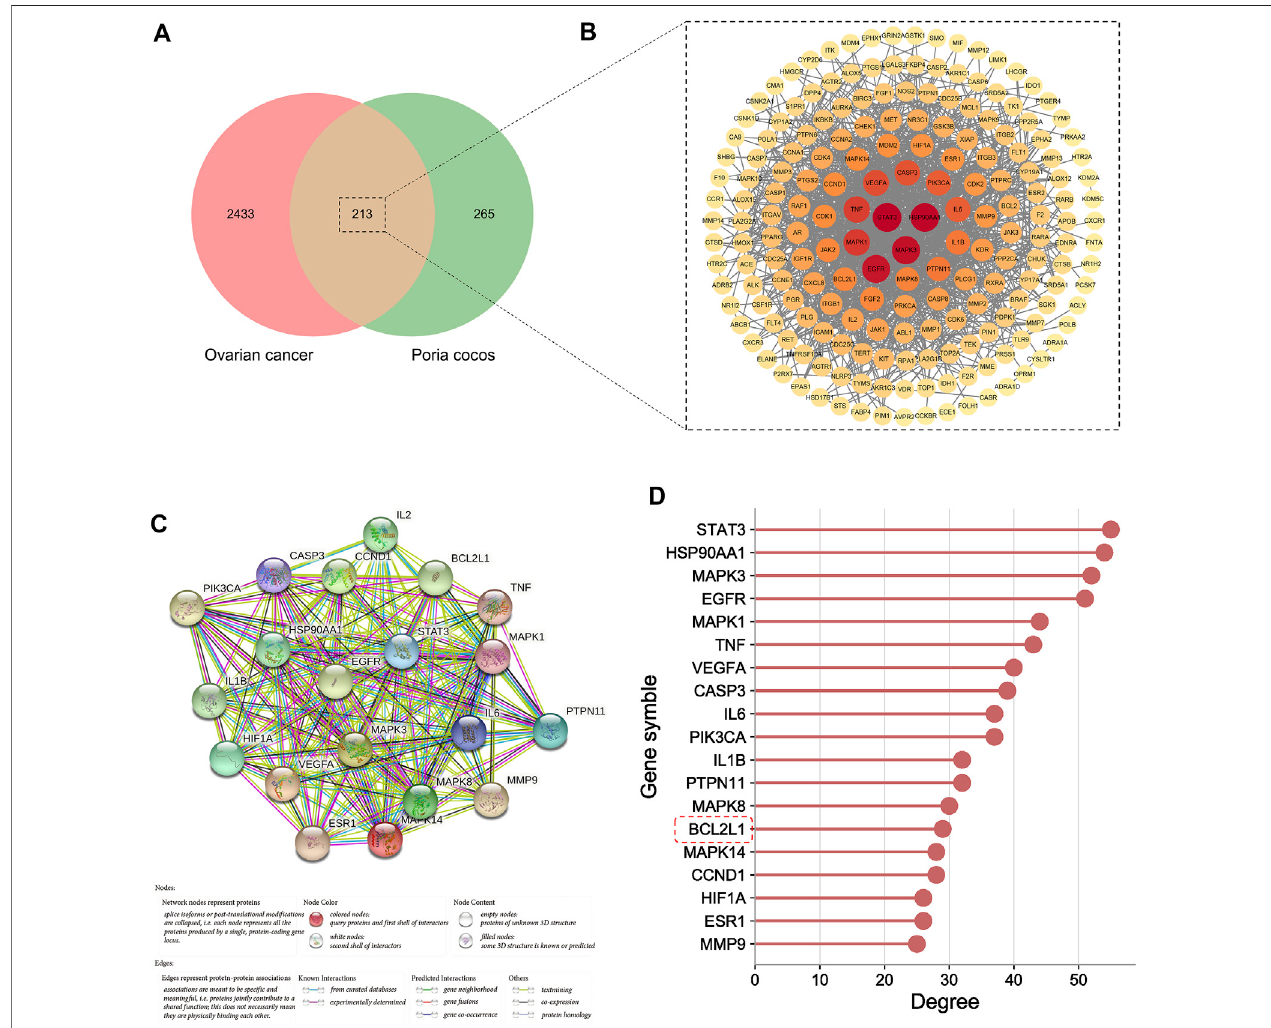
FIGURE 5 | The process of core target screening. (A) The Venn diagram of Poria cocos and OC targets. (B) The PPI network of intersection targets. (C) The PPI network of core targets. (D) The degree value of core targets.